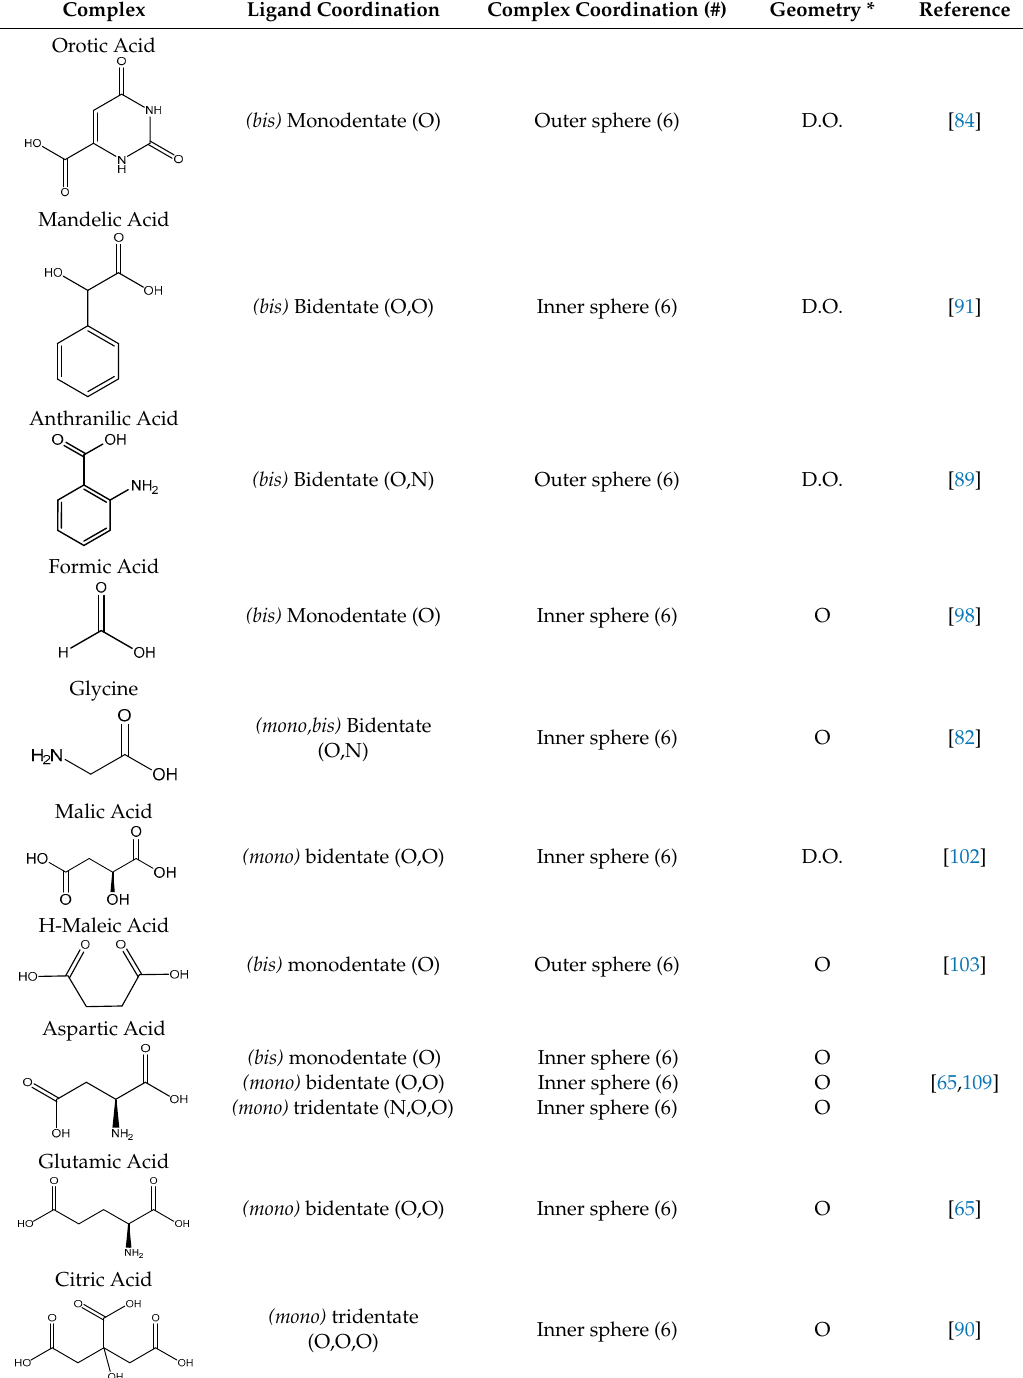
Table 5. Complete summary of all reviewed complexes including ligand coordination modes, complex coordination, and complex geometry. This table does not include those complexes reported by Yang et al. Yang supplies a full summary in his initial work [120]. The asterisk (*) denotes a shorthand to define complex geometry as either octahedral (O), distorted octahedral (D.O.), pseudo-octahedral (P.O.), tetrahedral (T), distorted tetrahedral (D.T.), or square planar (S.P.). The pound (#) indicates the coordination number of the described magnesium complex (i.e., the species is six-coordinate).